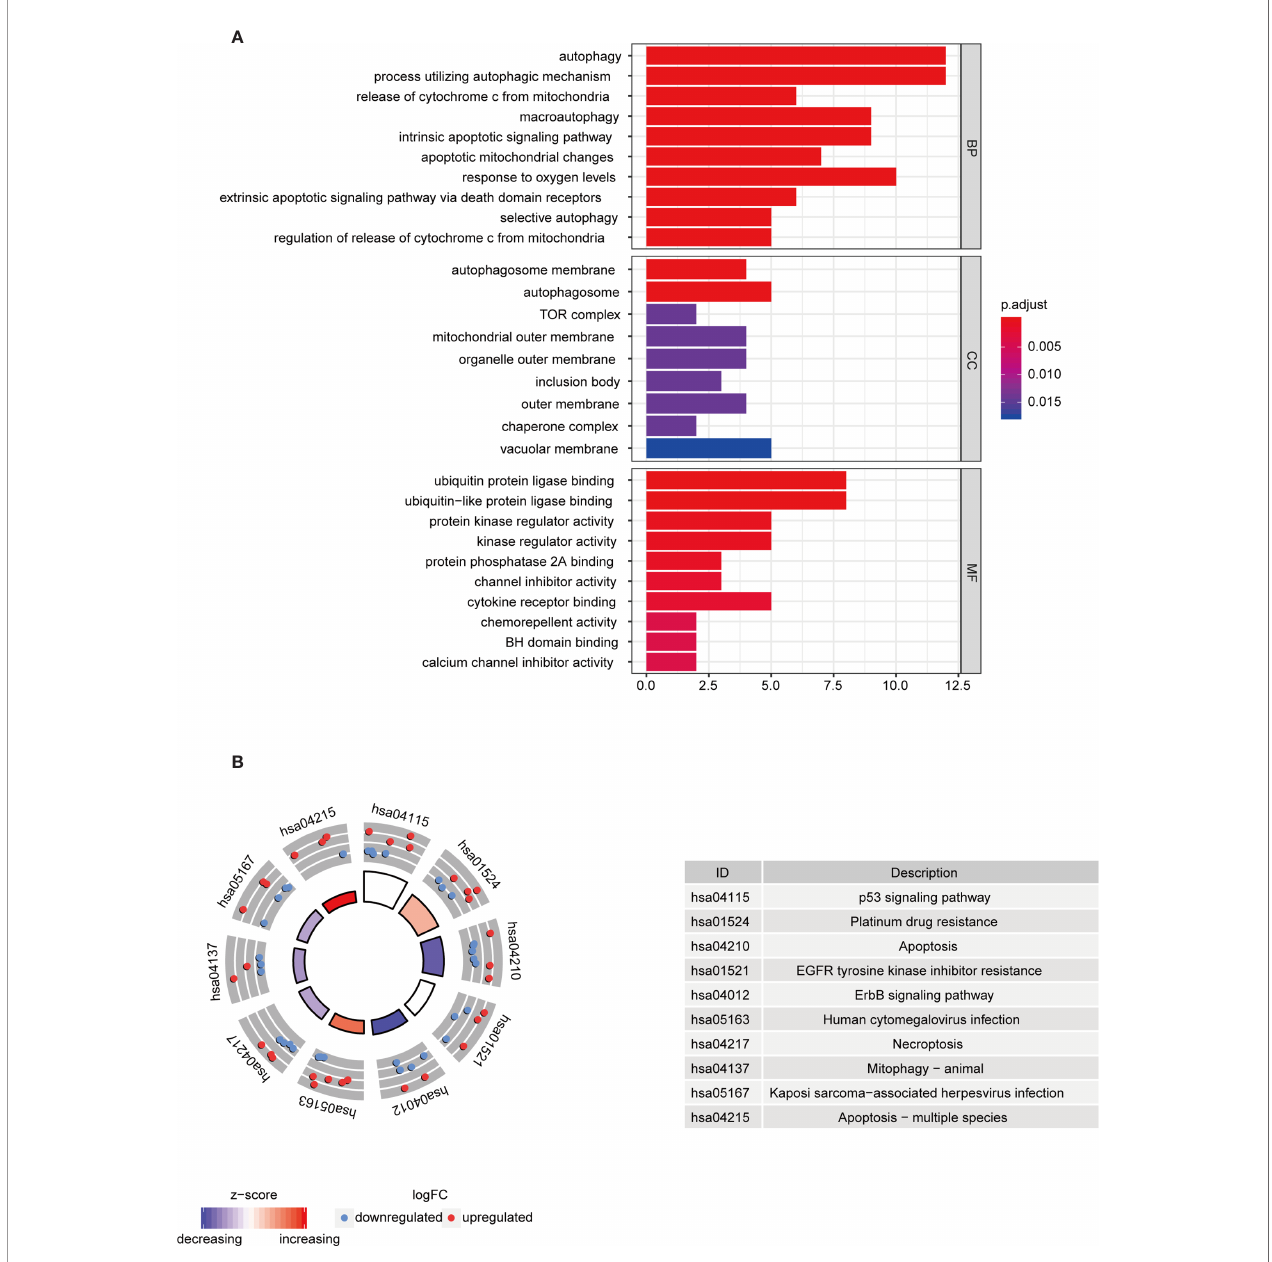
FIGURE 2 | Functional analysis of differential autophagy genes. (A) GO analysis: top 10 gene functions for each category. Red end indicates high correlation; blue end indicates low correlation. BP, CC and MF, biological function, cellular component composition and molecular function. (B) KEGG analysis: top 10 gene enrichment pathways. Red circles indicate up-regulation and blue circles indicate downregulation. Different colors of the inner circles indicate the overall expression of genes clustered in this category. GO, Gene Ontology; KEGG, Kyoto Encyclopedia of Genes and